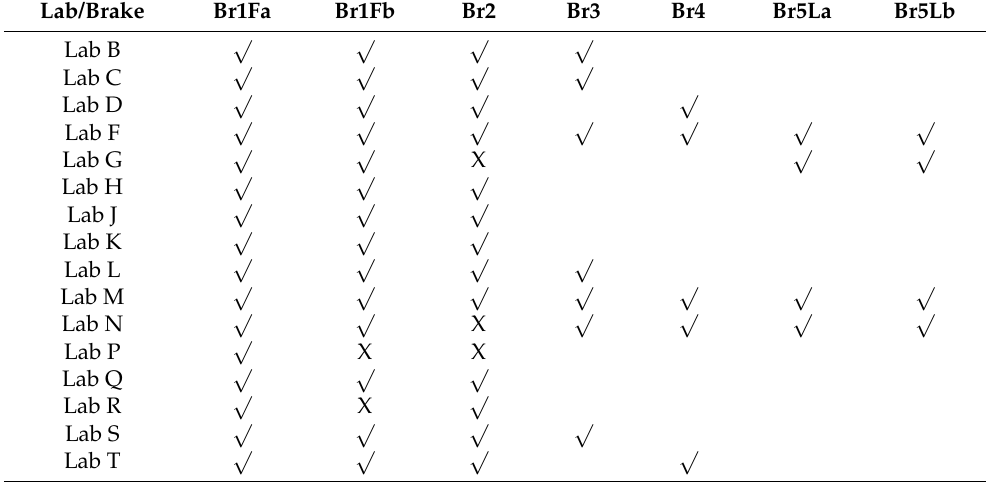
Table 4. Final execution status of the ILS test